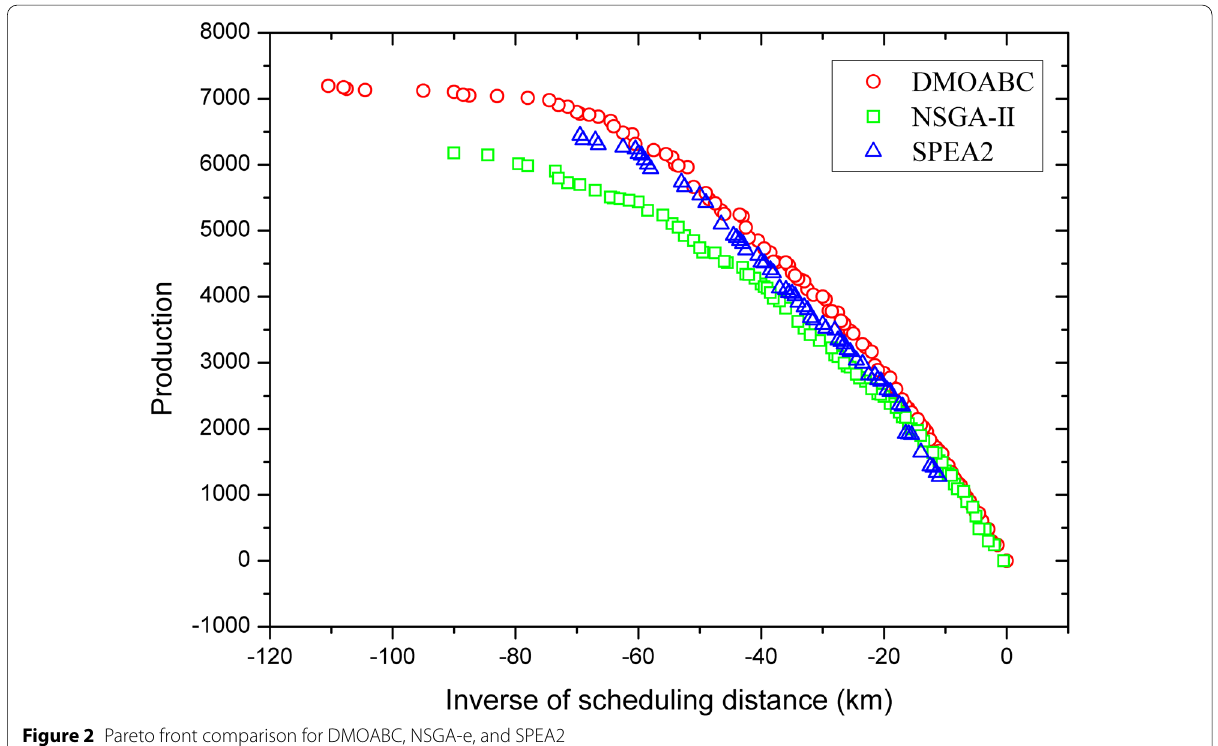
Figure 2 Pareto front comparison for DMOABC, NSGA-e, and SPEA2